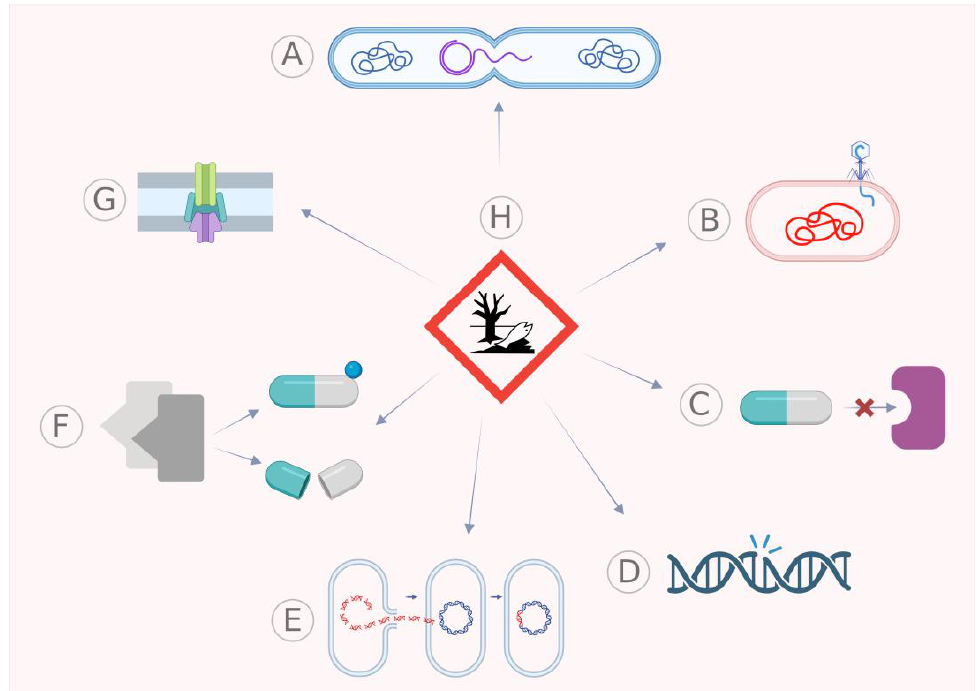
Figure 1. Various mechanisms and factors that play a significant role in the regulation of genes encoding virulence and antimicrobial resistance. ( A ) Conjugation; ( B ) transfection; ( C ) alteration of the antibiotic target; ( D ) elevated mutation rates; ( E ) transformation; ( F ) inactivation of antibiotics; ( G ) efflux pump; with ( H ) environmental factors exerting a secondary and ultimate effect on all the others. Created with Biorender.com.